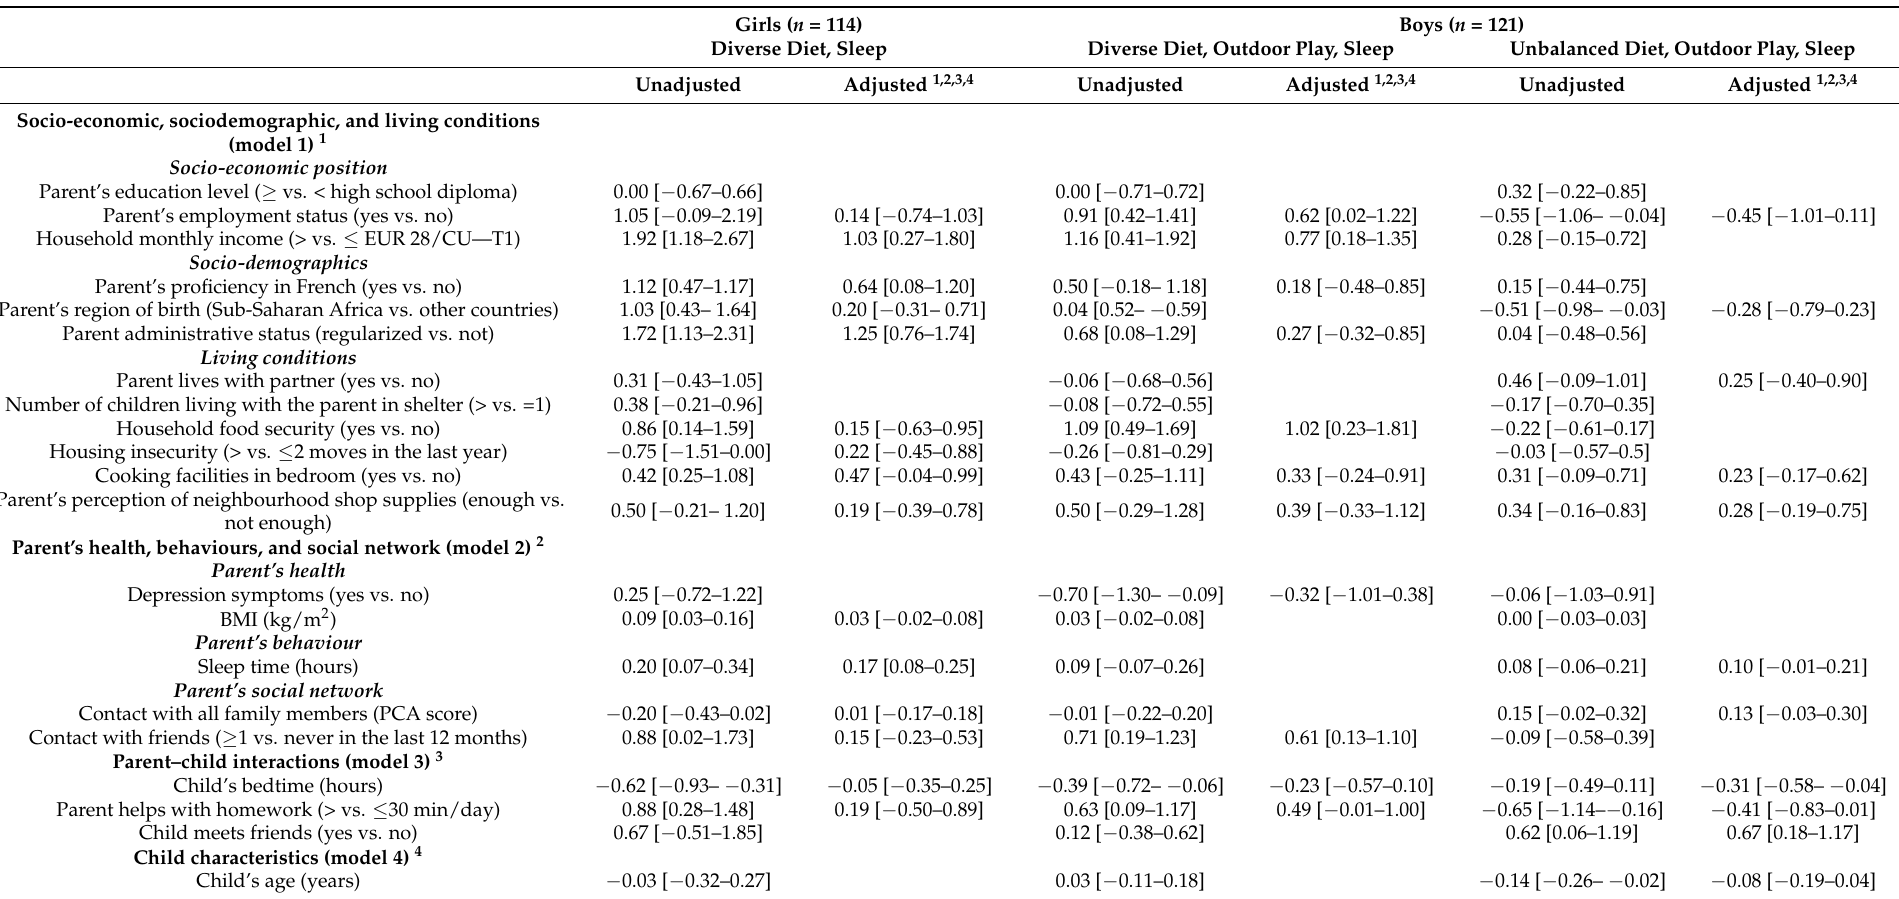
Table 3. Associations ( β [95% CI]) between family socio-ecological factors and lifestyle patterns in girls and boys: unadjusted and adjusted models. The ENFAMS